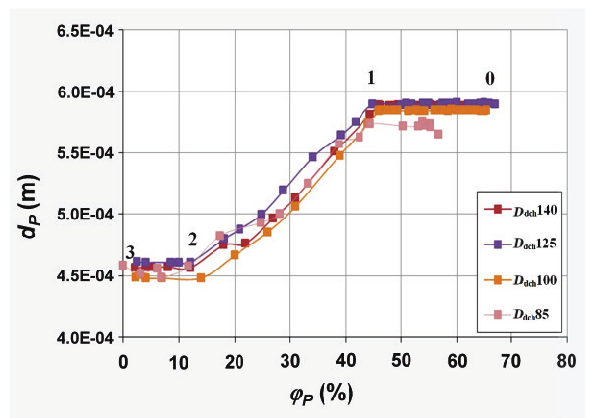
Fig. 7 – Dependence of the change in particle diameter on the relative moisture of the particles